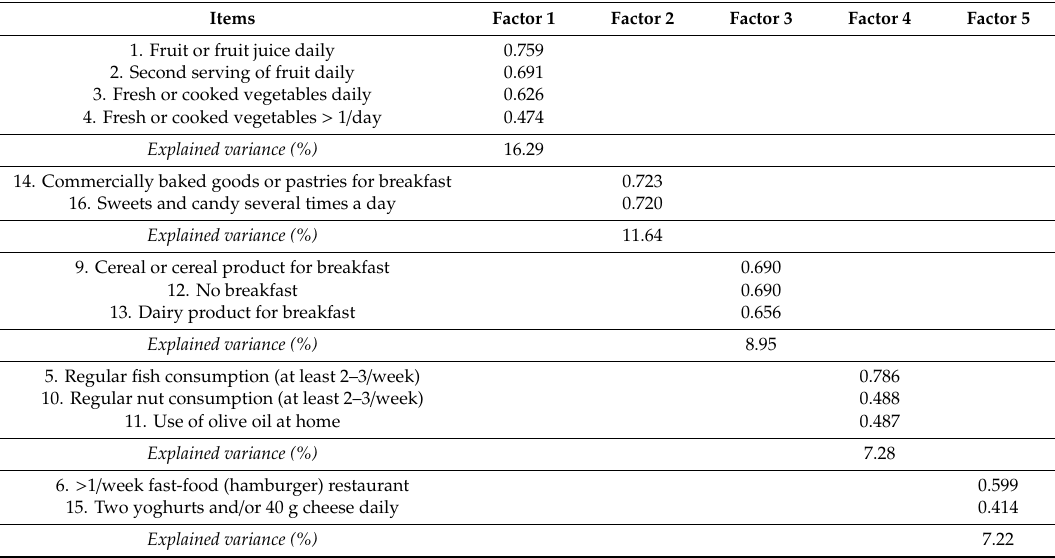
Table 3. Results from principal component analysis (PCA) and exploratory factor analysis